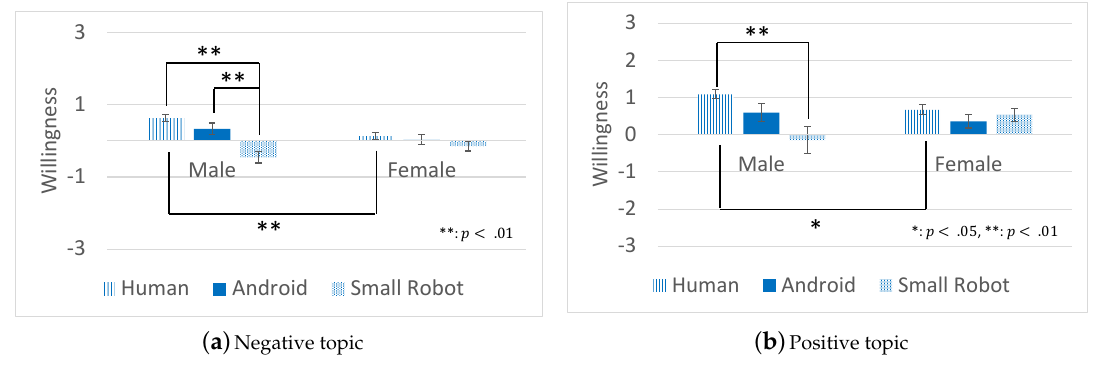
Figure 6. Willingness to self-disclose (The error bars show the standard errors).